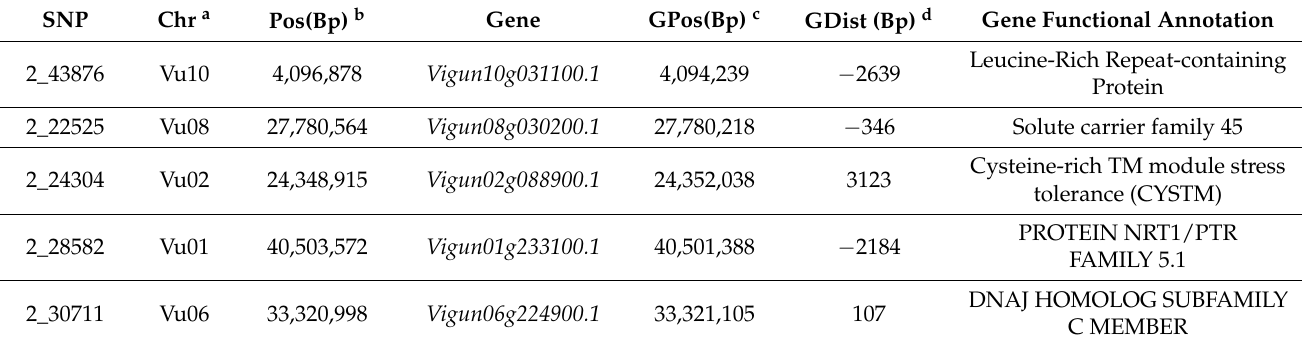
Gene Functional